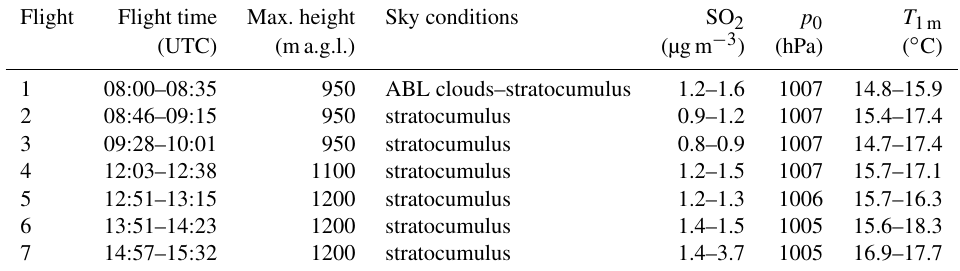
Figure 5. Backscatter signals (range corrected at the wavelength of 532nm) of Polly XT lidar installed at Melpitz on 21 June 2015. White parts show clouds and colour scales in green up to red show the existence of atmospheric particles. More details of the lidar can be taken from Engelmann et al. (2016). Table 2. Performed airborne measurements with the UAS ALADINA during MelCol experiment Case II on 21 June 2015. The flight time of ALADINA between take-off and landing and the maximum altitude of flights. In addition, prevailing conditions of clouds, SO 2 gas concentration, pressure at surface p 0 and temperature T 1m from mast in 1m height are presented in relation to corresponding flight time